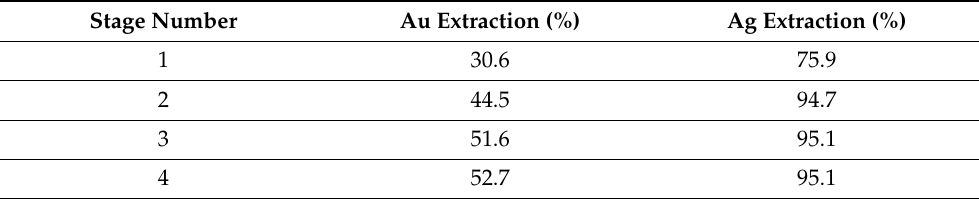
Table 3. Gold and silver cumulative dissolution yields as a function of stage number.